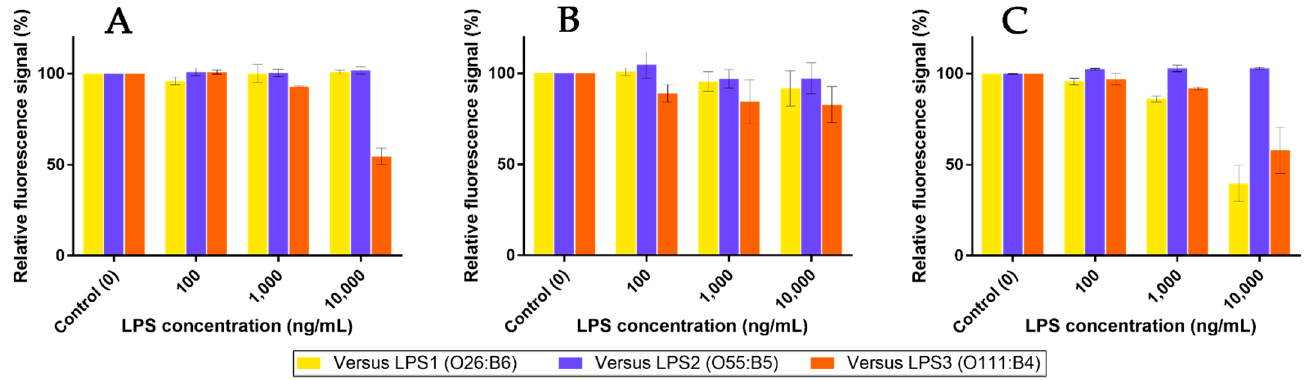
Figure 16. Competition assays of Mf 24% bonded to fixed hMBL ( A ), hSP-D ( B ), and pSP-D ( C ) versus LPS at different concentrations (0.1, 1, and 10 µg/mL).